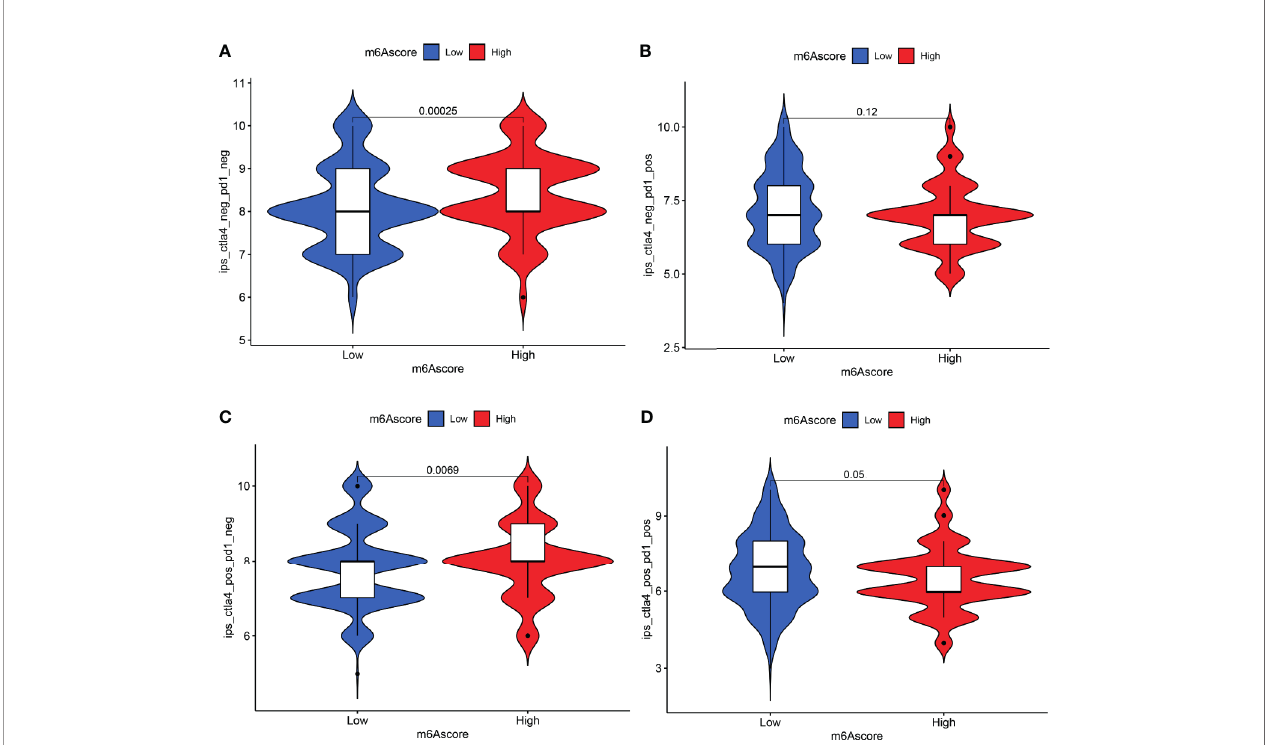
FIGURE 7 | Analysis of m6A modi fi cation patterns in anti-PD-L1 and CTLA-4 immunotherapy. (A) Differential analysis for low-m6A score group and high-m6A score group in CTLA-4 negative and PD-L1 negative therapy. (B) Differential analysis for low-m6A score group and high-m6A score group in anti-PD-L1 immunotherapy. (C) Differential analysis for low-m6A score group and high-m6A score group in anti-CTLA-4 immunotherapy. (D) Differential analysis for low-m6A score group and high-m6A score group in anti-PD-L1 combined with CTLA-4